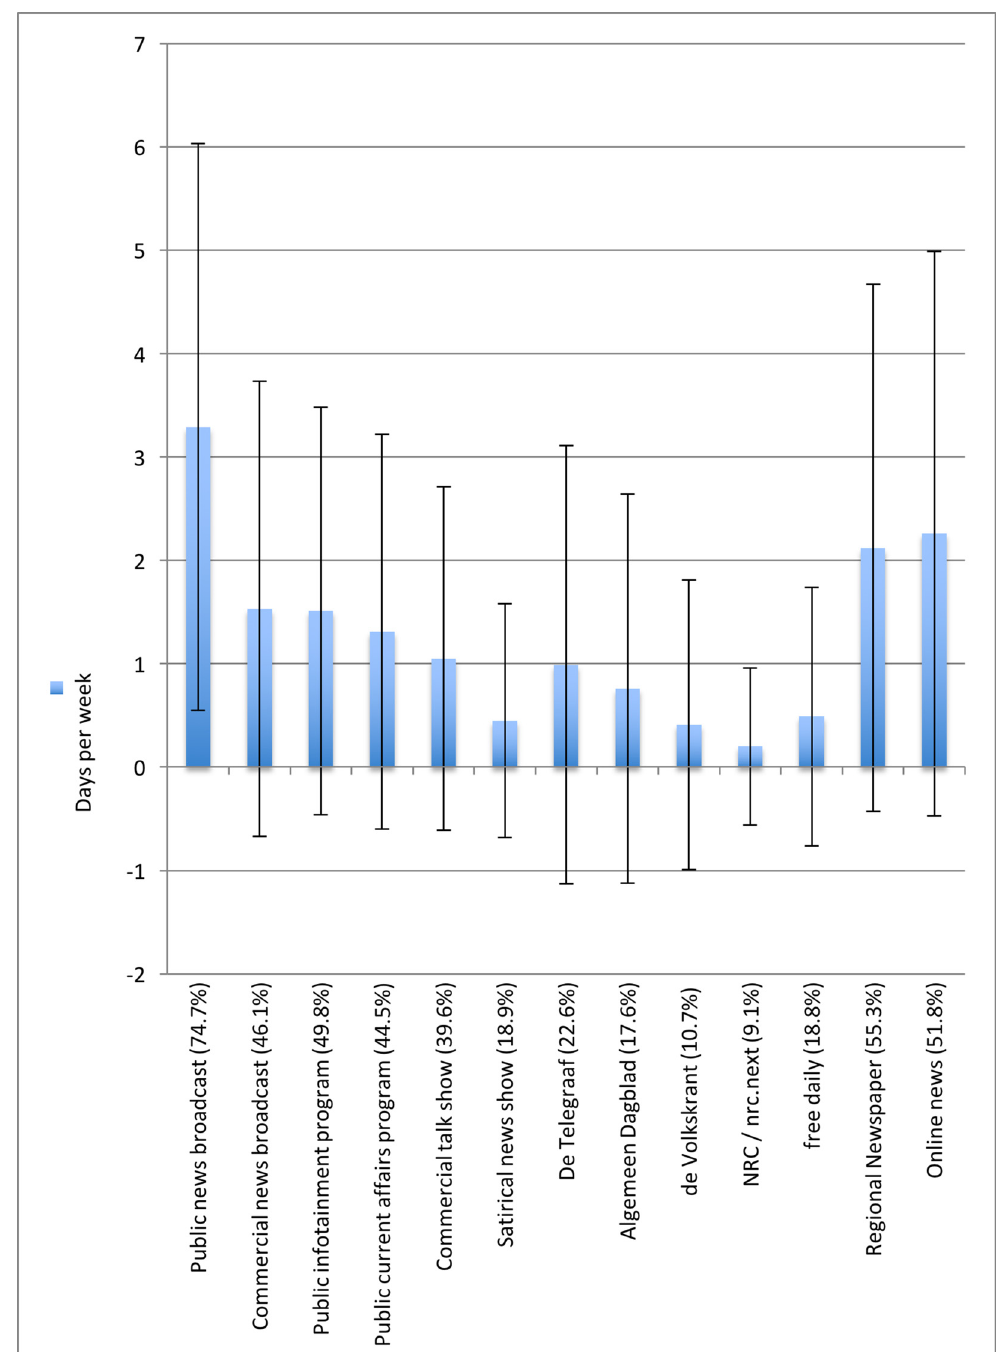
Fig 1. Most popular News and Current Affairs Sources. For parsimonious reasons we only presented one outlet within the main television news categories. The results are similar for other outlets within the same category, and available from the authors upon request. Public News broadcast = NOS Journaal , Commercial news broadcast = Hart van Nederland , similar results for RTL Nieuws , Right-wing satirical news show = Pownews , Public Infotainment program = DWDD , Public current affairs program = Nieuwsuur , similar results for Pauw & Witteman and EénVandaag ; Commercial talkshow = RTL Late Night ; Free daily = Metro , similar results for Sp ! ts ; online news = nu . nl , similar results for newspapers online and “ other news websites ” Bars show exposure to each outlet in average number of days per week (Mean), error bars show standard deviation, labels show percentage of respondents indicating they use source at least once per